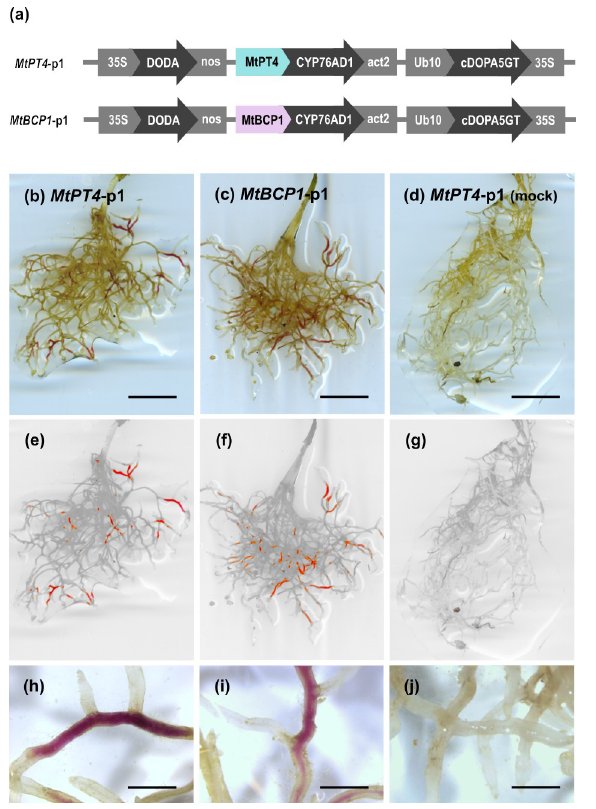
Fig 2. Betalains can be produced in Medicago truncatula roots as a response to AM fungi colonisation. (a) Schematic of the multigene vectors constructed for inducible betalain expression in M . truncatula roots where only the first gene of the betalain biosynthesis pathway is controlled by AM symbiosis–specific promoters. Expression of MtPT4 -p1 (b, e, and h) and MtBCP1 -p1 (c, f, and i) in roots of M . truncatula 4 weeks after inoculation with Rhizophagus irregularis . (d, g, and j) Example of MtPT4 -p1 expressing root system mock inoculated with autoclaved R . irregularis . (e, f, g) Root system images filtered for red colouring only. Scale bar (b, c, and d), 1 cm; scale bar (h, i, and j), 1.5 mm. AM, arbuscular mycorrhiza.